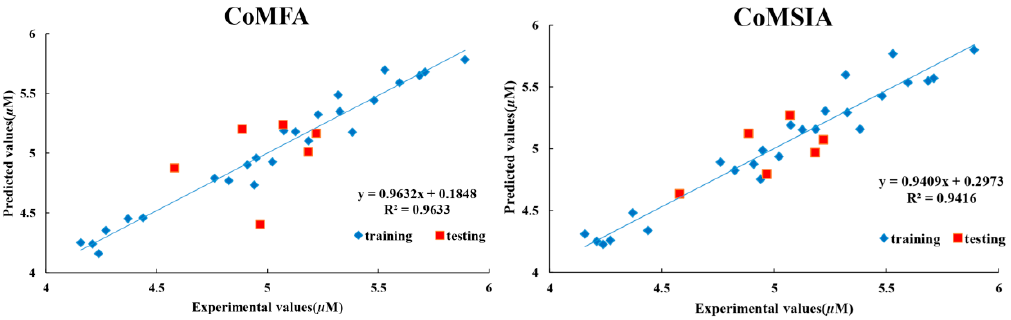
Figure 6. Plot of experimental and predicted pLC 50 for the CoMFA and CoMSIA models.